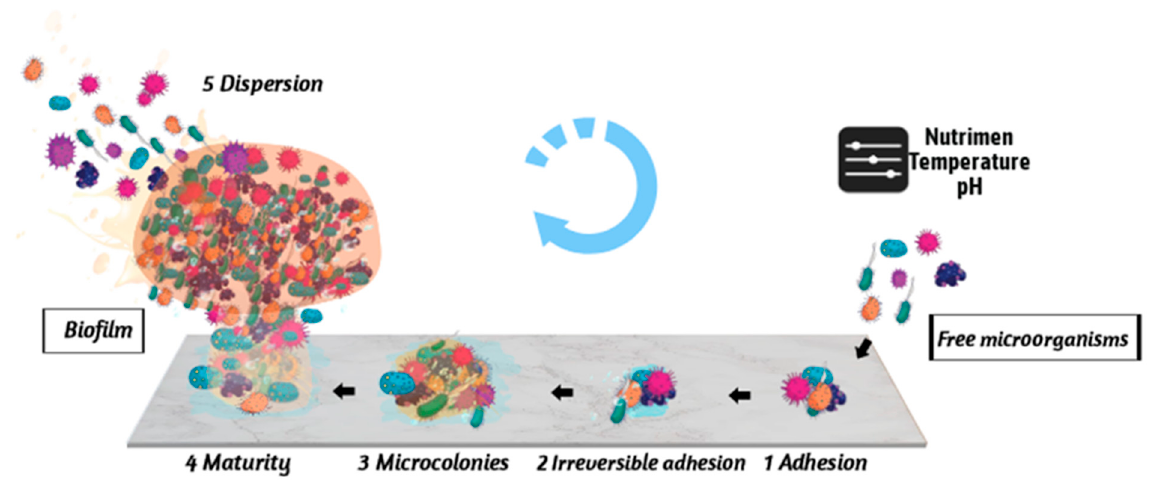
Figure 1. Schematic diagram of microbial biofilm formation. When the environmental conditions (nutrients, temperature, pH, etc.) are adverse, the free microorganism actively and reversibly adheres to the carrier surface, and then secretes EPS (blue) to further enhance the adhesion between the microorganism and the carrier by forming irreversible adhesion. Then, the microorganism grows and propagates to form colonies, and biofilm (yellow) is formed on the surface. After the increase in microorganisms, the biofilm is mature, becoming mushroom-like and with a three-dimensional structure. With the increase in microorganisms in the biofilm, they disperse from the biofilm to form new free microorganisms. As the cycle continues, microorganisms can survive in harsh environments.